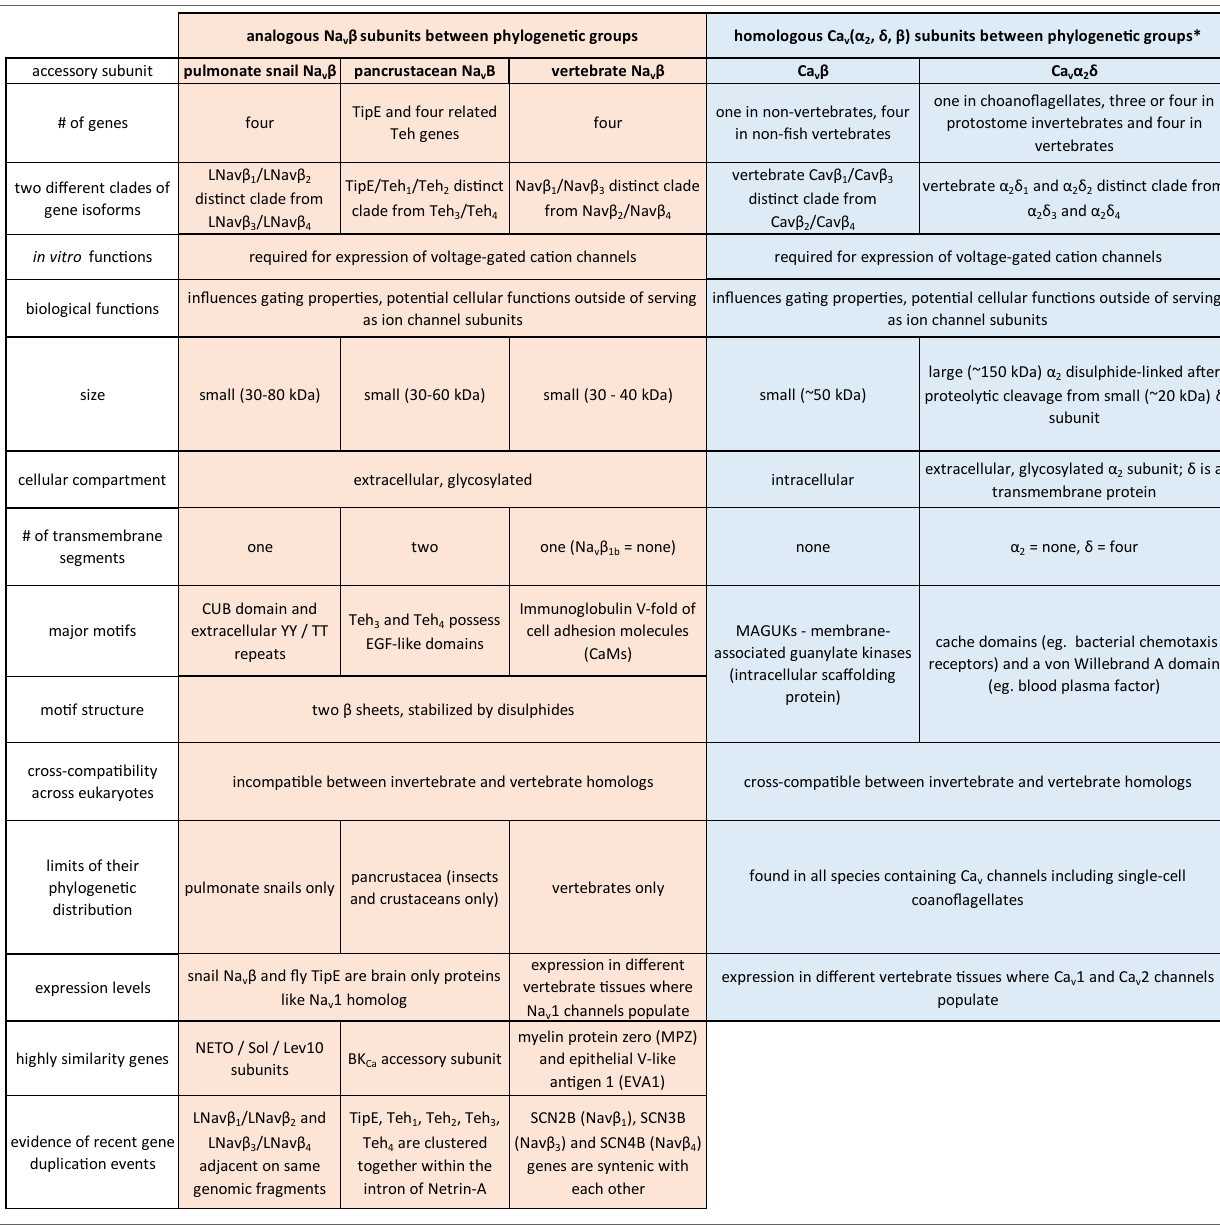
Neto2, CUB domain containing proteins, co-assemble with vertebrate glutamate receptors (NMDA and kainite) to modulate their channel gating and enhance their membrane trafficking (Wyeth et al., 2014). The common thread between the Na v β subunits is cellular adhesion involving extracellular motifs, but in different structural forms within CUB domains (gastropod snails) (Fux et al., 2016), EGF-like domains (insects) (Derst et al., 2006), or Ig V-fold (vertebrates) (Isom et al., 1995;